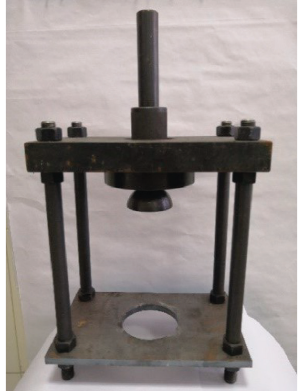
Figure 3: Space drawing instrument.